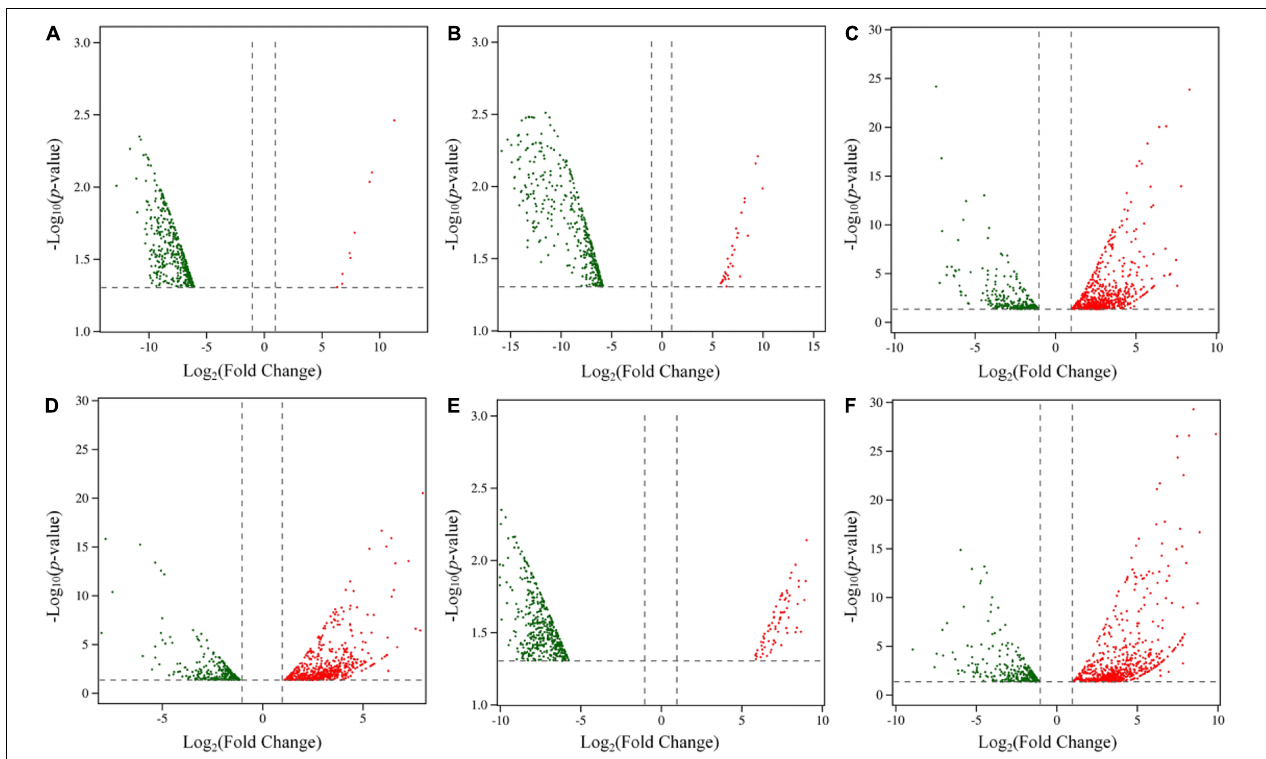
FIGURE 3 | Volcano plots (A–F) were used to illustrate the characteristic of differentially expressed genes (DEGs) in six treatments. (A) 0.07 µ m MPs. (B) Cu-NPs + 0.07 µ m MPs. (C) 0.7 µ m MPs. (D) Cu-NPs + 0.7 µ m MPs. (E) 7 µ m MPs. (F) Cu-NPs + 7 µ m MPs. The x-axis represents the fold change of each gene on a log 2 scale (fold change < 0.5 or fold change > 2). The y-axis represents the significance level of each gene on a –log 10 scale ( p -value < 0.05). Each dot represents a gene. Red dots represent up-regulated genes. Green dots represent down-regulated